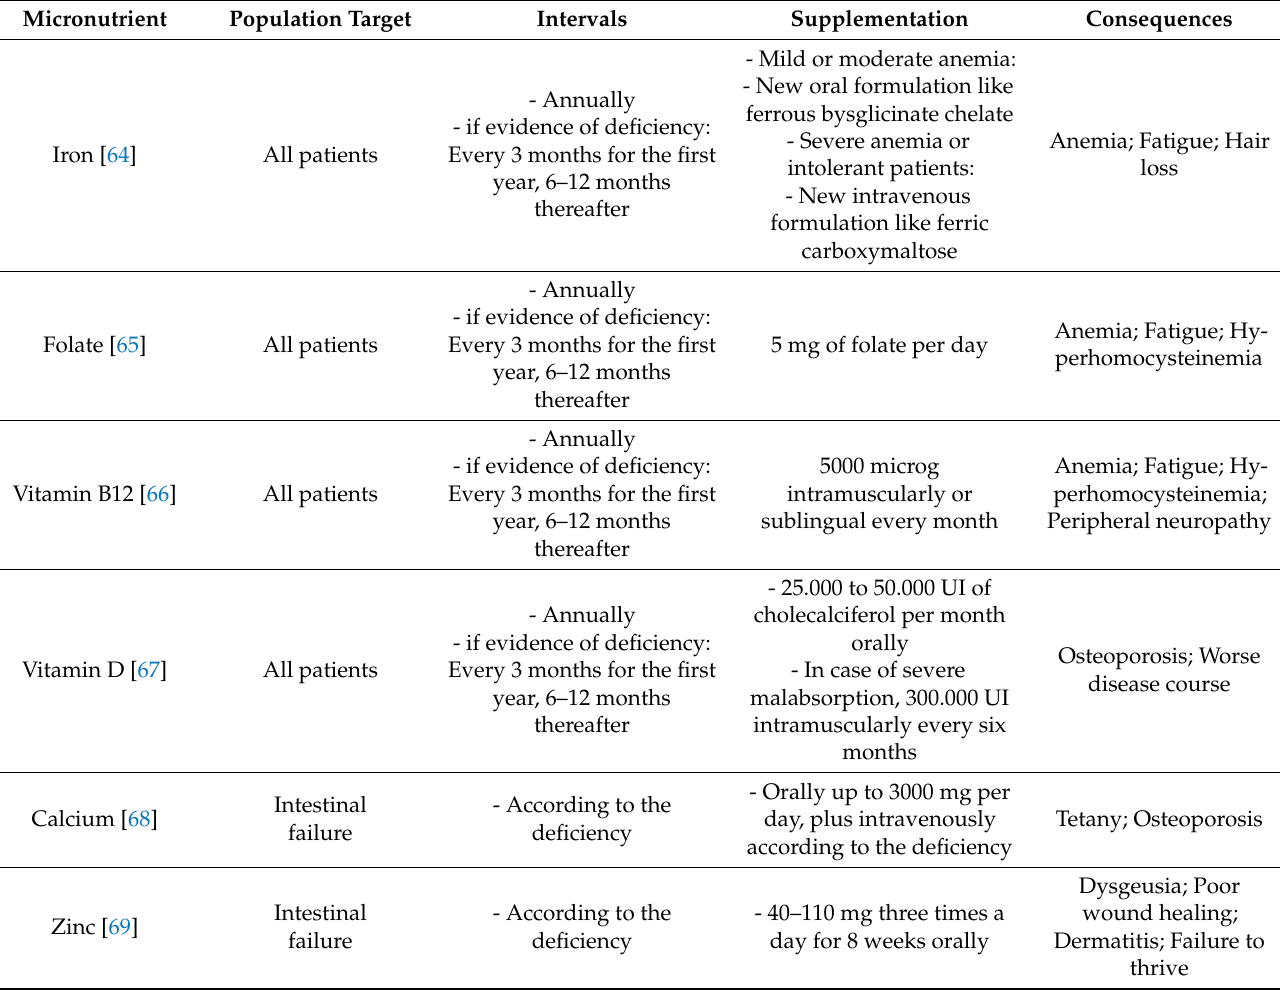
Table 1. Micronutrients deficiency in patients affected by